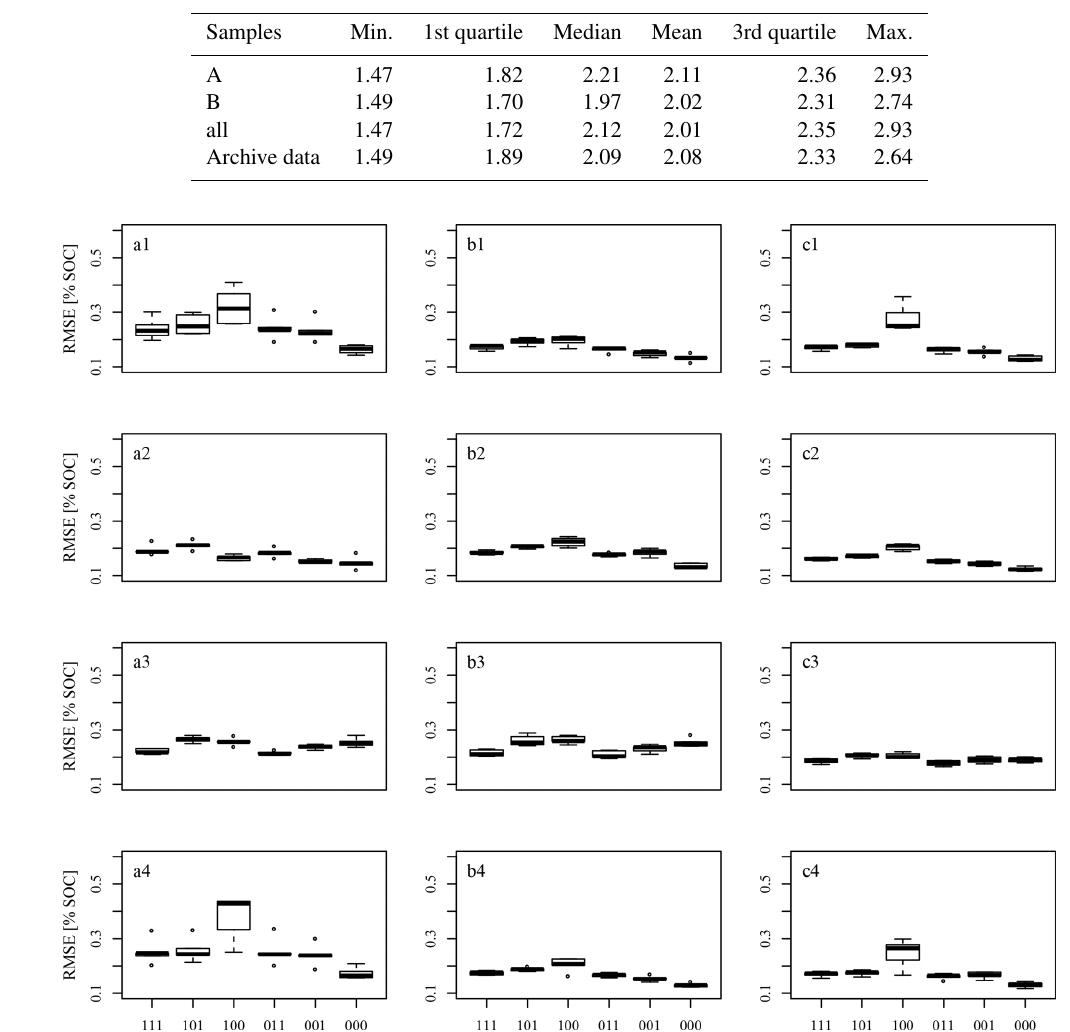
Figure 8. Boxplots of test-set RMSE MV obtained with the various datasets. Figure columns refer to datasets using (a) A samples, (b) B samples, and (c) all samples. Figure rows refer to the applied pre-processing, 1 − SG, 2 − SGCR, 3 − SNVd1, 4 −